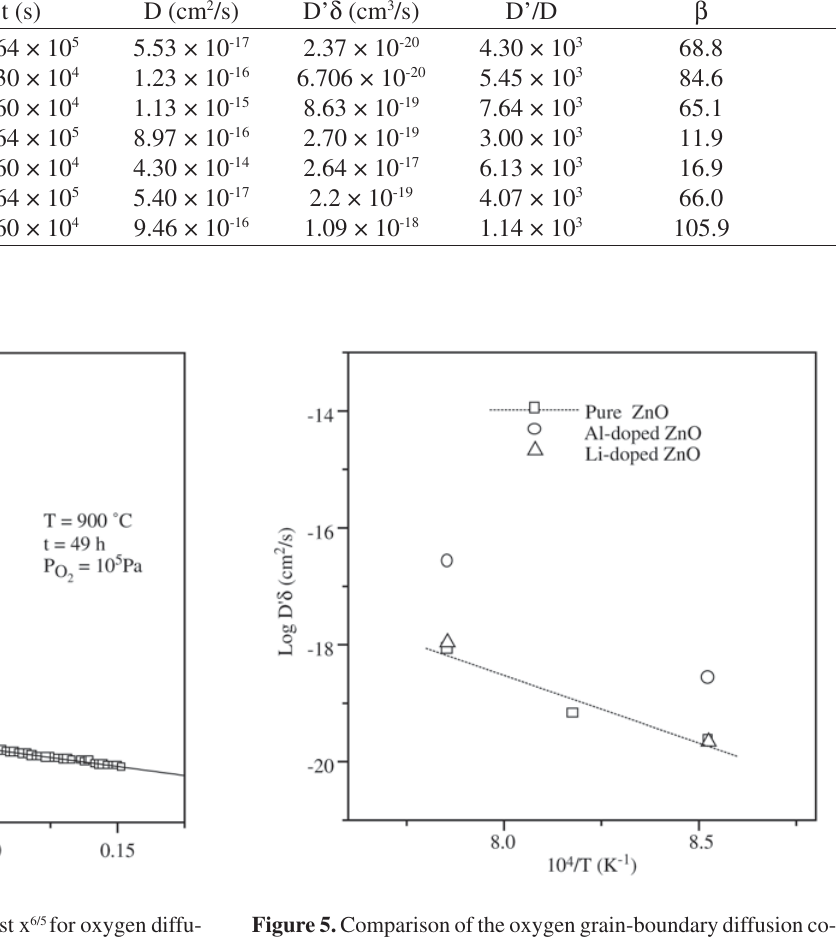
Figure 4. Oxygen concentration plot against x 6/5 for oxygen diffu- sion in pure ZnO (900 °C, oxygen pressure 10 5 Pa, 1.764 ×10 5